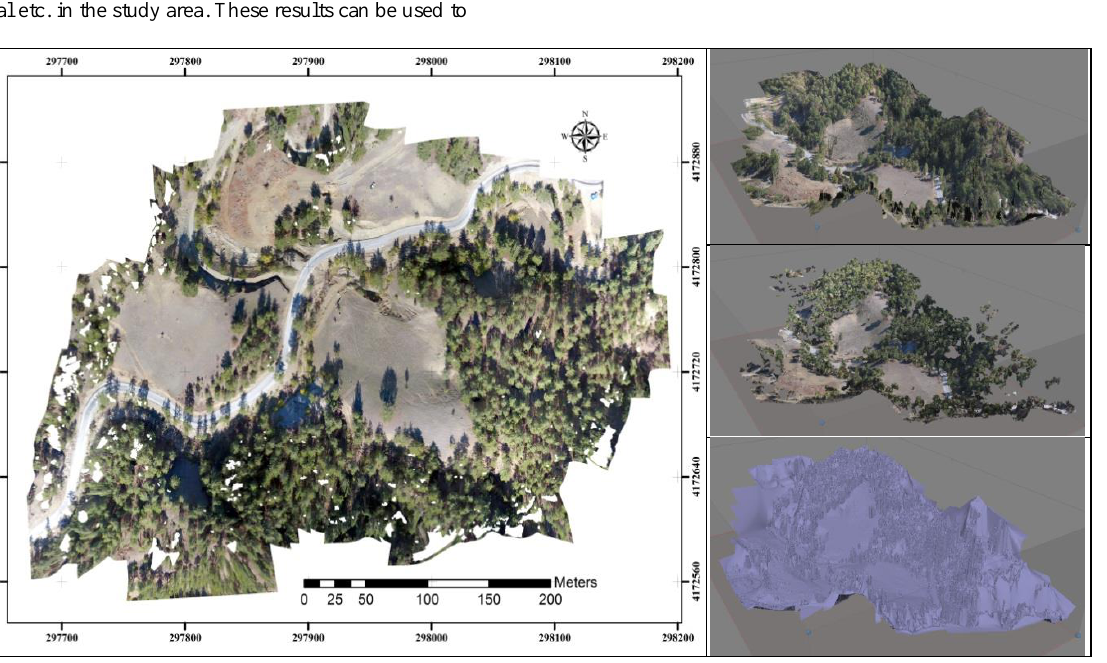
Figure 4. Generated point cloud data by using PhotoScan in